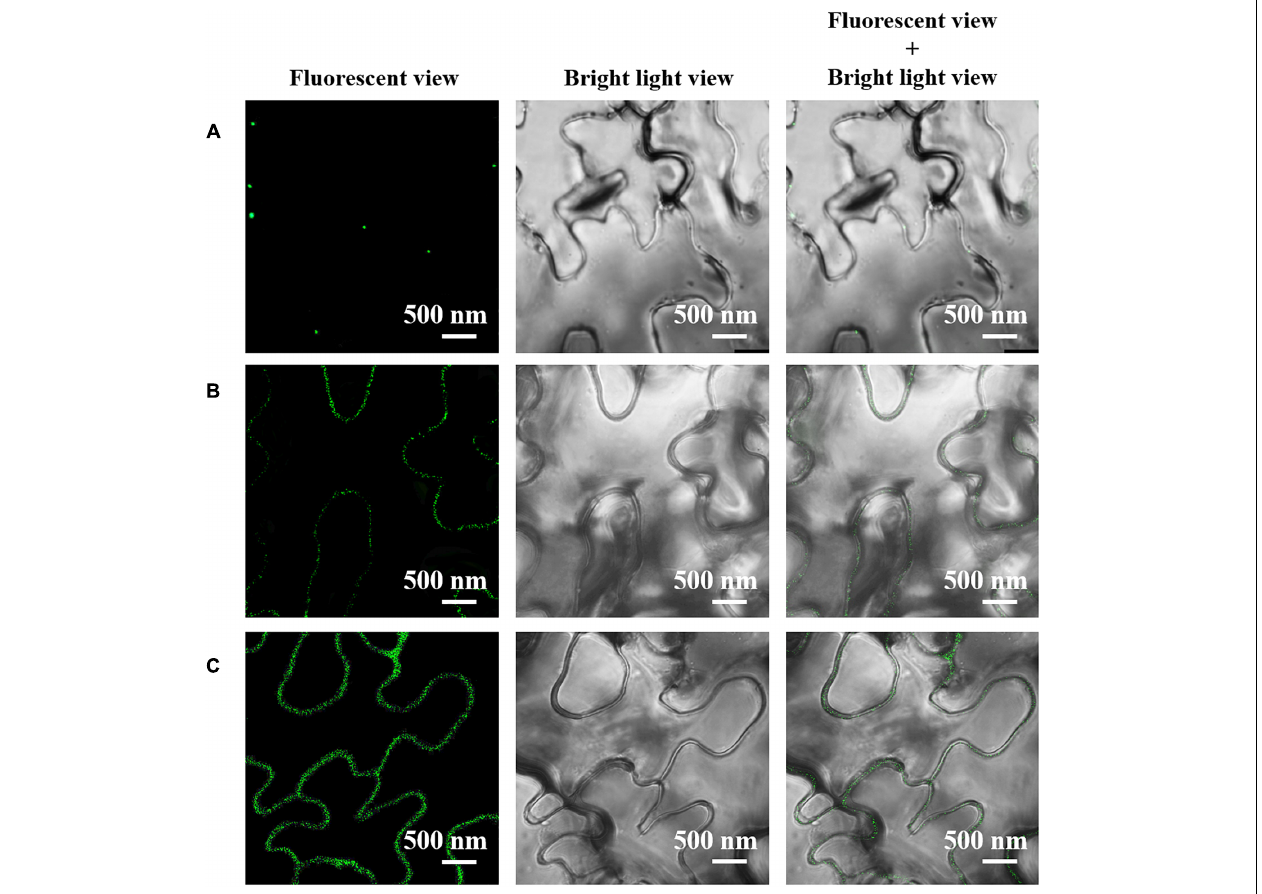
FIGURE 4 | The CLSM images of the immune fluorescent labeled AGP in Arabidopsis hypodermis cells in the presence of Ce(III) at 0 (A) , 30 (B) , and 80 µ M (C) . The immune fluorescent labeling was carried out 12 h after the treatments of